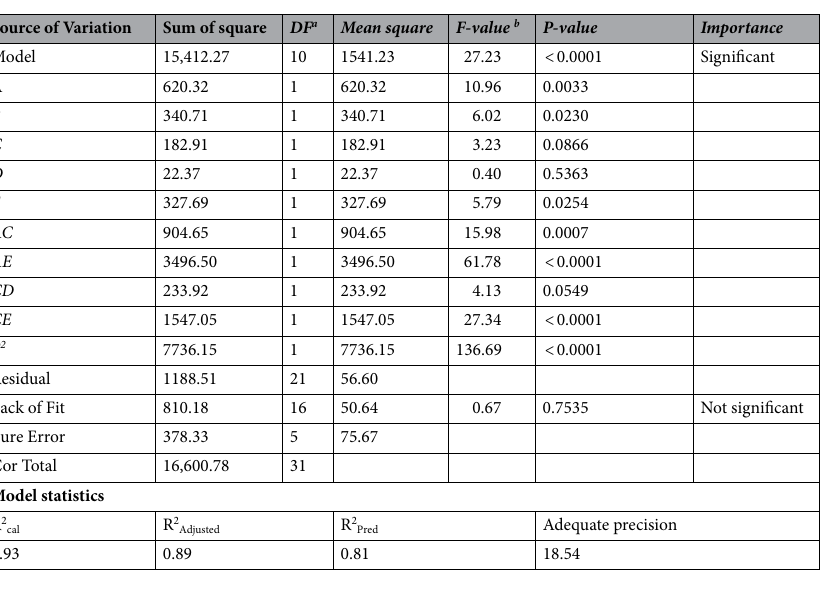
Table 2. Analysis of variance (ANOVA), model statistics summery and quality of the quadratic model for the extraction of t,t-MA. a Degree of freedom. b Test to comparing model variance with residual variance or significance of included